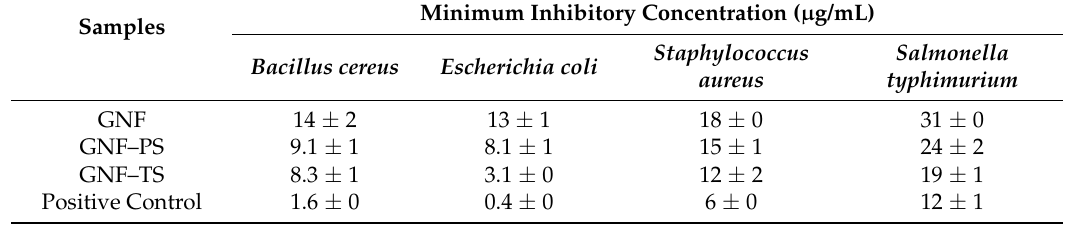
Table 3. Antibacterial activity of the GNF and its PS and TS bionanocomposites, with 5% GNF, in comparison with the